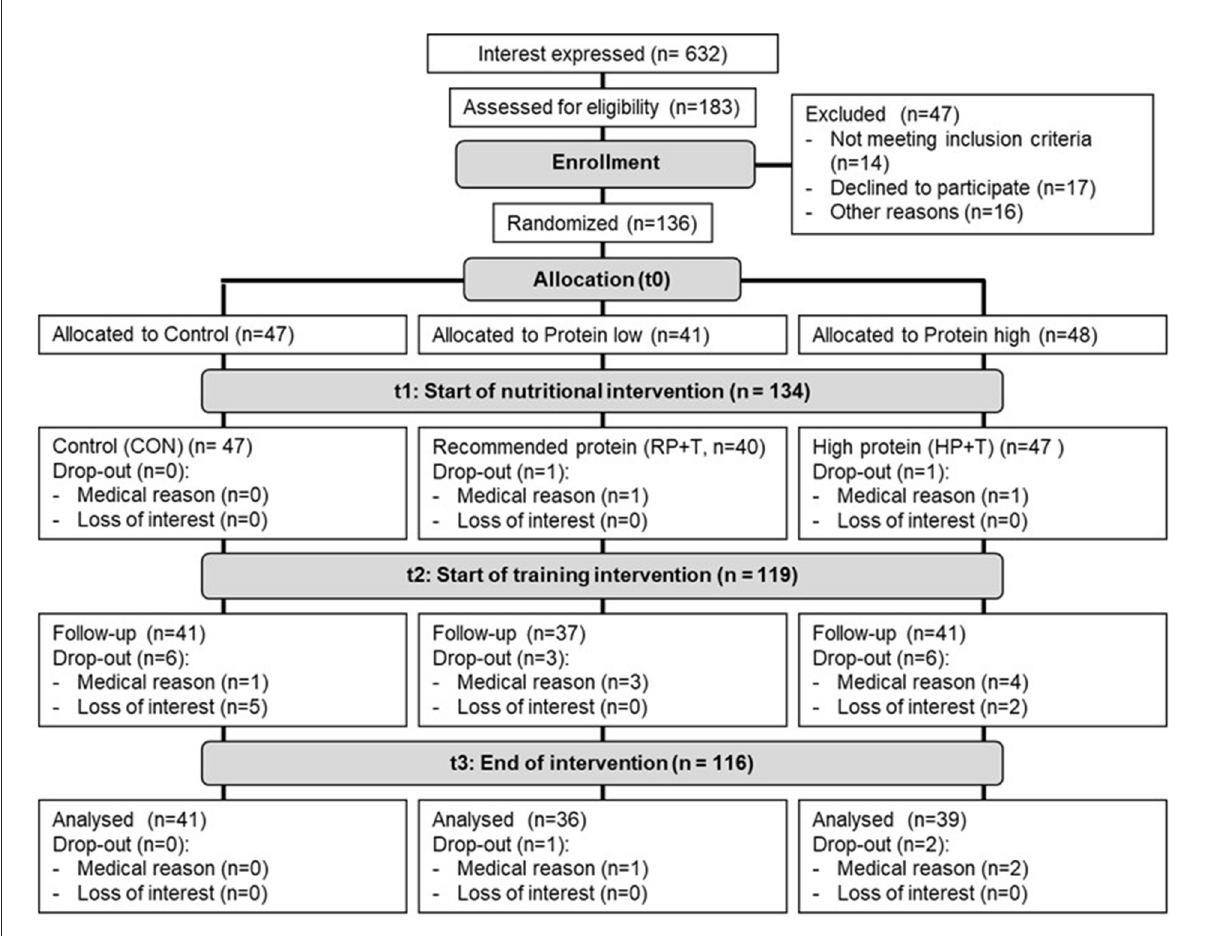
FIGURE2 Participants’